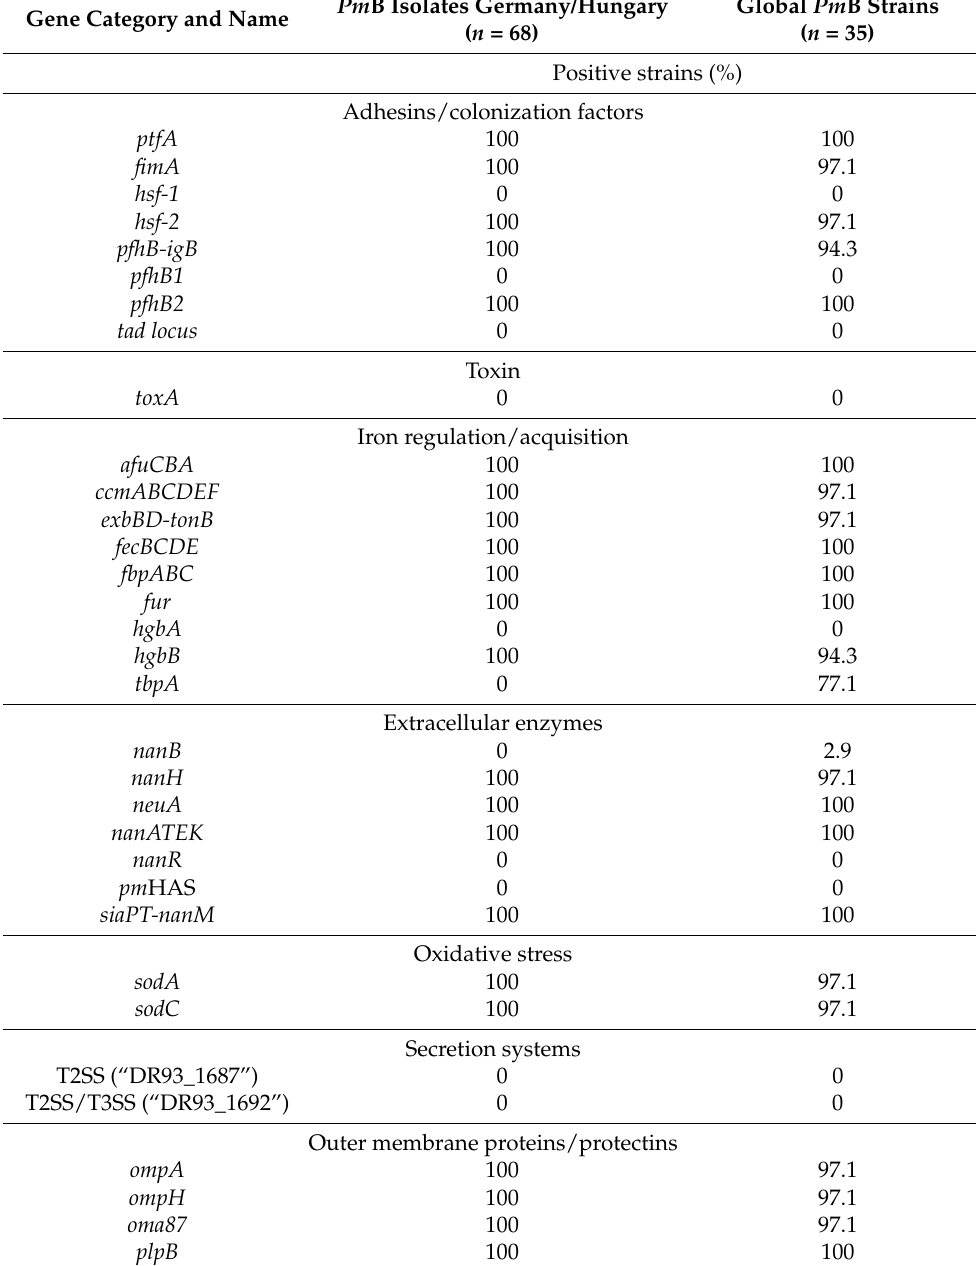
Table 1. Distribution of virulence-associated genes among 103 Pm B-ST122 strains. Gene Category and